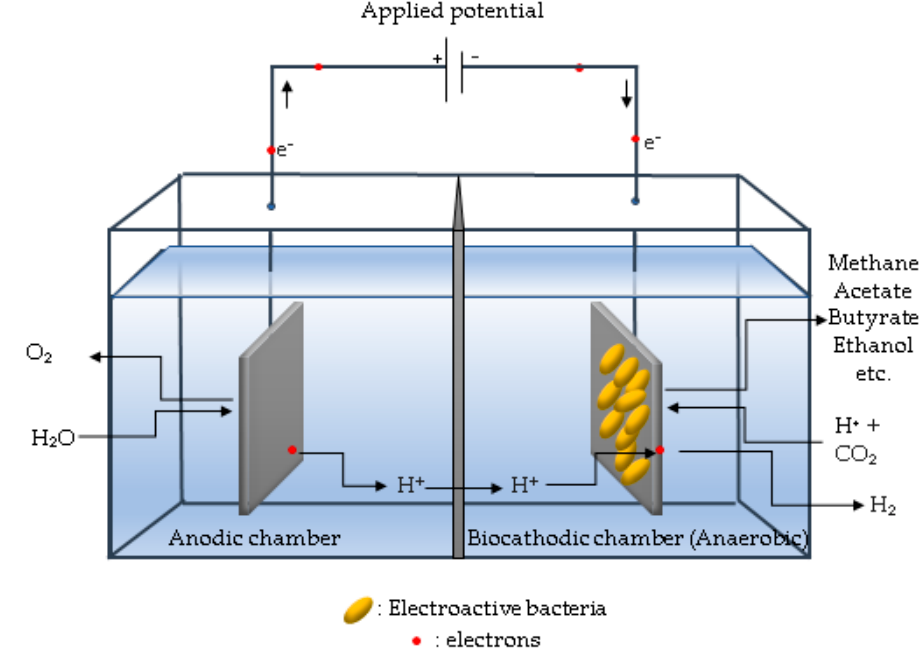
Figure 6. Bioelectrochemical system for CO 2 reduction to chemicals and fuels.